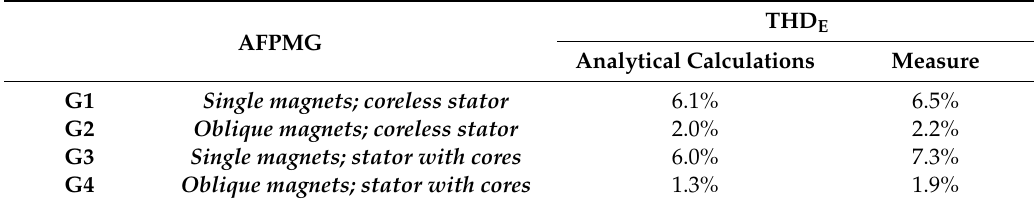
Table 2. Comparison of the results obtained from analytical models and laboratory tests for THD factors of